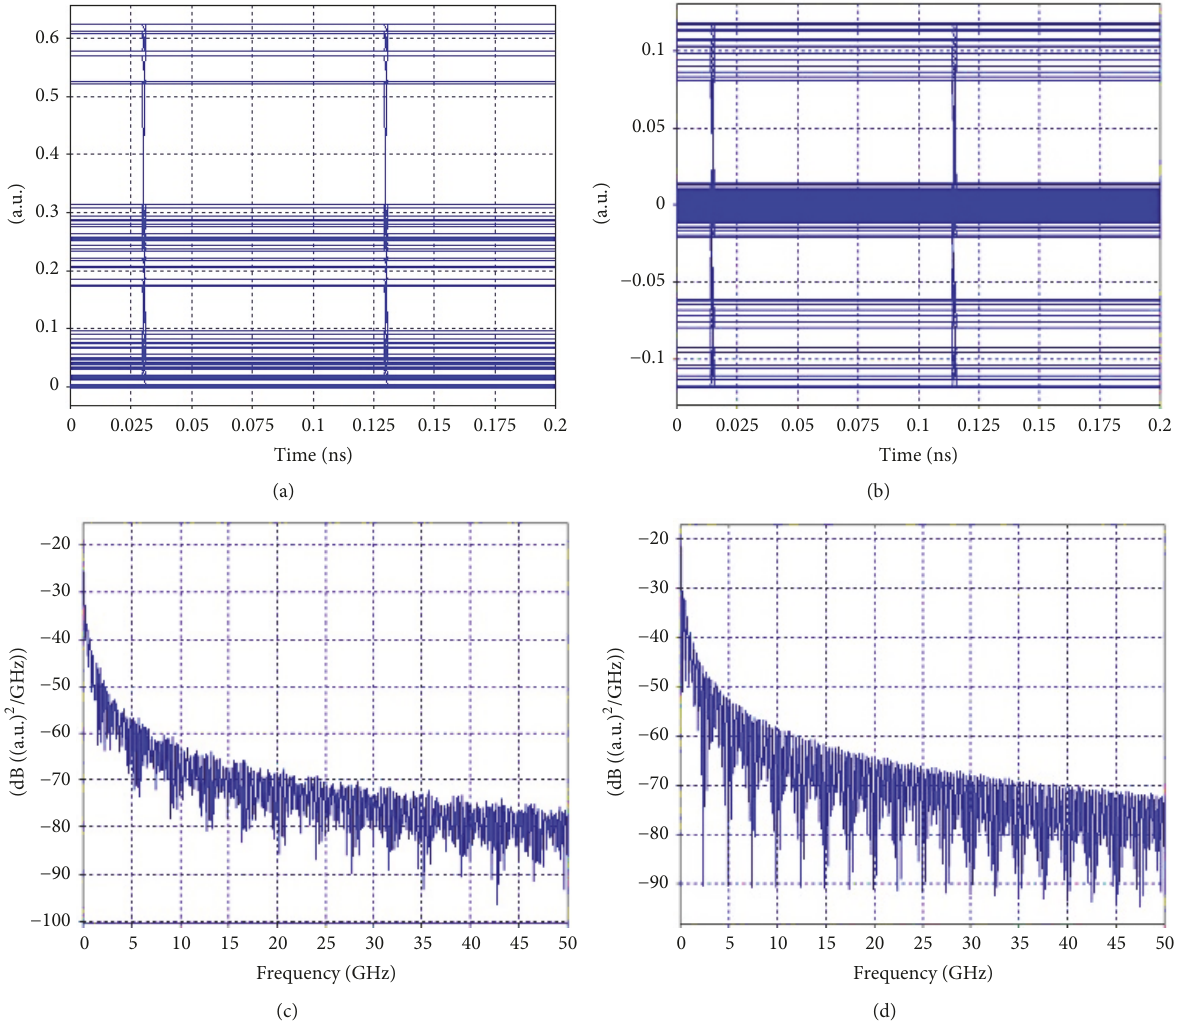
Figure 3: (a) Eye spectra in case of an optical I/Q modulator, (b) eye spectra in case of a direct modulator, (c) frequency spectra in case of an optical I/Q modulator, and (d) frequency spectra in case of a direct